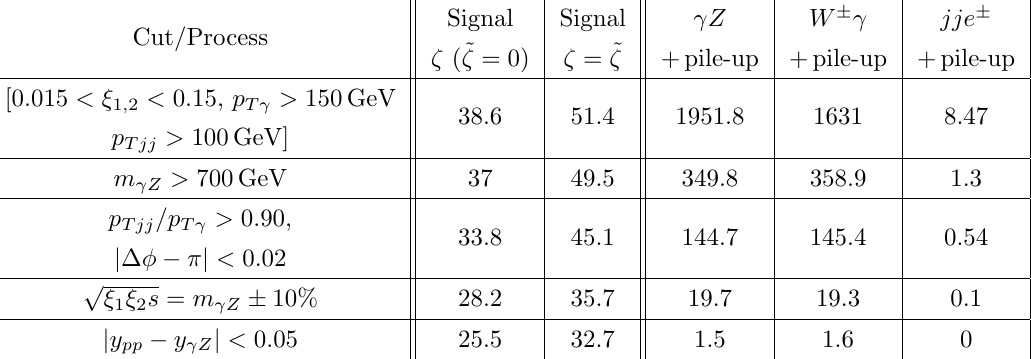
Table 1 . Number of signal and background events in the jj(cid:13) channel after the selection cuts for p an integrated luminosity of 300 fb (cid:0) 1 and (cid:22) = 50 at s = 13 TeV, and for (cid:16) = 4 (cid:1) 10 (cid:0) 13 GeV (cid:0) 4 . Non-exclusive events were simulated on PYTHIA8 at leading-order and signal events in the FPMC. Jets are reconstructed with the anti- k t clustering-algorithm using R = 0 : 5 and p T min = 10 GeV.